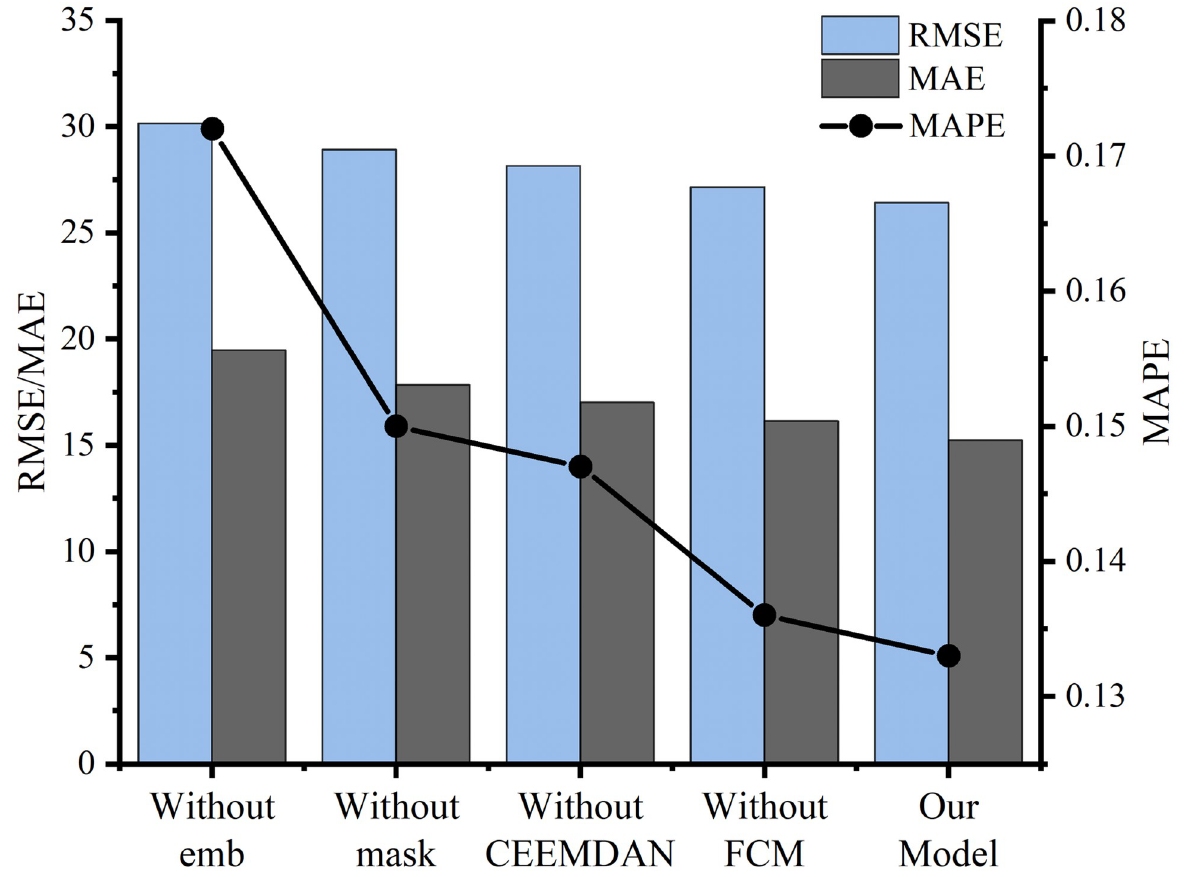
Fig 11. Prediction performance of different